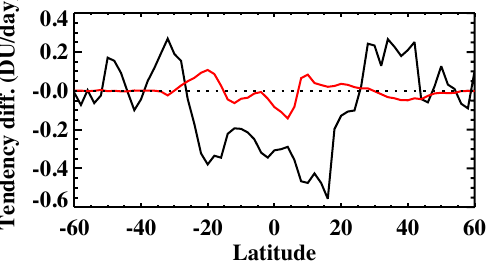
Figure 6. The dynamical (black) and convective (red) ozone ten- dency differences between months of strong El Niño and La Niña conditions from the assimilation system over 2005–2013. The means are calculated between 180 and 120 ◦ W, matching that of Fig.